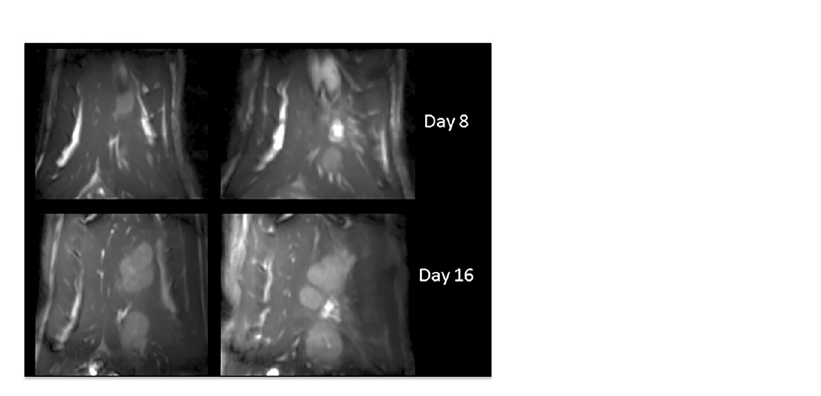
Fig 4. MR imaging. Coronal contrast enhanced MRI images for the same rat at 8 and 16 days post injection of tumor cells, demonstrating rapid increase in tumor